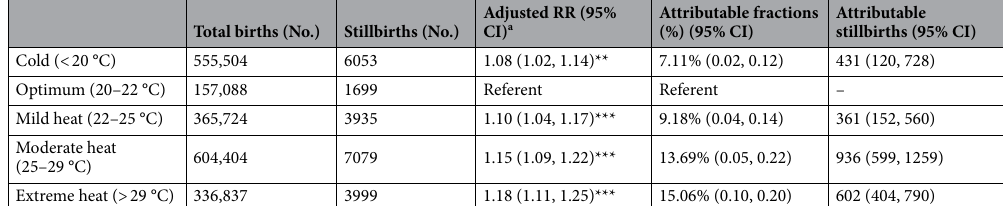
Table 1. Relative risk and attributable fraction of stillbirth related to mild, moderate, and extreme heat. RR, relative risk; CI, confidence interval. * p -value < 0.05, ** p -value < 0.01, *** p -value < 0.001. a Adjusted for relative humidity. The Akaike information criterion (AIC) for the model was